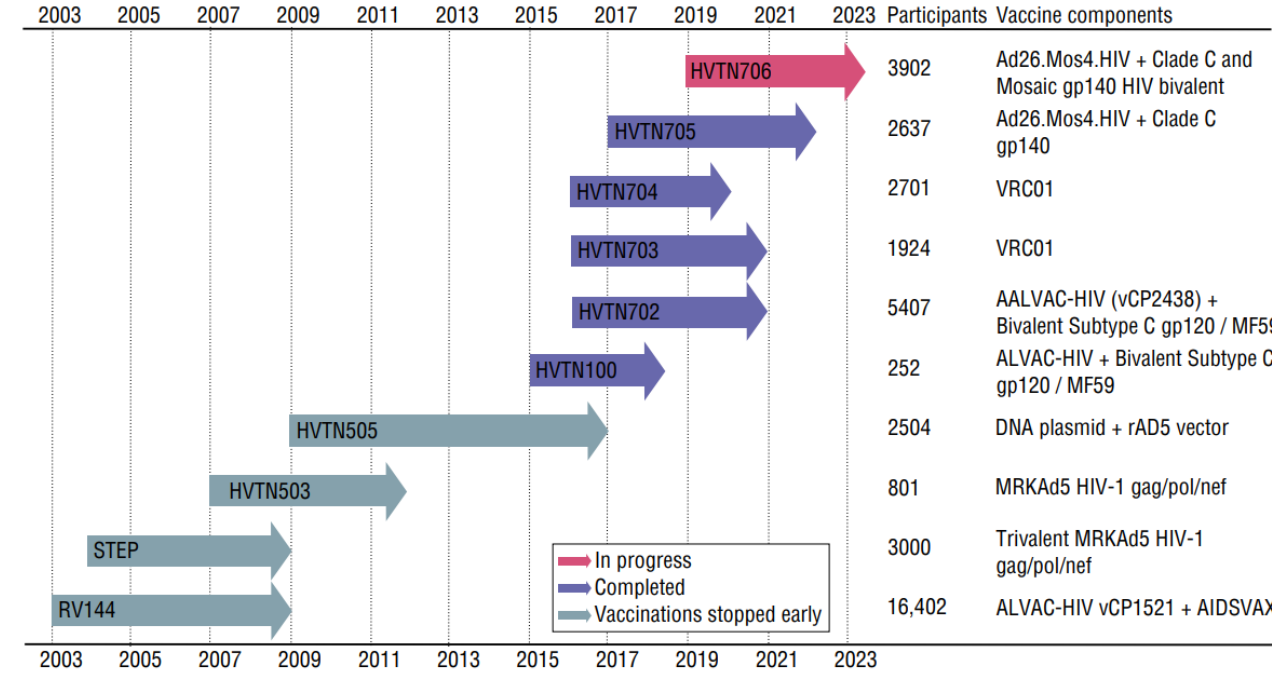
Figure 4. HIV-1 vaccine trial history. Arrows indicate spans of time and are color coded based on their progress. The number of participants and vaccine descriptions are noted. Starting at the left, the RV144 trial (2003–2006, monitoring until 2009) showed a modest 31% efficacy result [51]. The STEP study (2004–2007, monitoring until 2009) found that vaccinated participants were at a higher probability of HIV-1 infection if they had prior high levels of antibodies against the vector, adenovirus serotype 5 [52]. HVTN503 , also known as the Phambili trial (2007, monitoring until 2012), used a MRKad5 gag/pol/nef HIV-1 subtype B vaccine, similar to the STEP trial. It was stopped within a few months, due to the STEP results. Although similar to the STEP trial, it did not result in an increased risk of HIV infection [53,54]. The HVTN505 trial (2009–2013, monitoring until 2017) was stopped due to a lack of efficacy. This trial looked at the efficacy of a DNA vaccine with clade B Gag, Pol, and Nef proteins and clade A, B, and C’s Env proteins. There was also a booster administered using a rAd5 vector that expressed clade B Gag-Pol fusion protein and clades A, B, and C’s Env glycoproteins [55]. The HVTN100 study (2015–2018) was the smallest clinical vaccine trial [56]. HVTN702 , the Uhambo trial (2016–2021), utilized two priming immunizations of subtype C envelope ALVAC-HIV and four boosters of a subtype C bivalent gp120 protein adjuvanted by MF59 [57]. The HVTN703 , or AMP trial (2016–2021), tested an intravenous antibody (VRC01). There were ten different infusions over the course of 72 total weeks [54]. In HVTN704 (2016–2020), AMP participants received the same treatment as the HVTN703 trial [50]. For the HVTN705 , or Imbokodo trial (2017–2022), a priming vaccination of Ad26.Mos4.HIV was administered at four different time periods with boosting adjuvanted vaccinations of Clade C gp140 protein administered twice [58]. The HVTN706 or Mosaico trial (2019–2024, expected) has a similar experimental design to HVTN705. This study administered the priming vaccinations of Ad26.Mos4.HIV at four different time periods with boosting vaccinations of Clade C and Mosaic gp140 protein administered twice